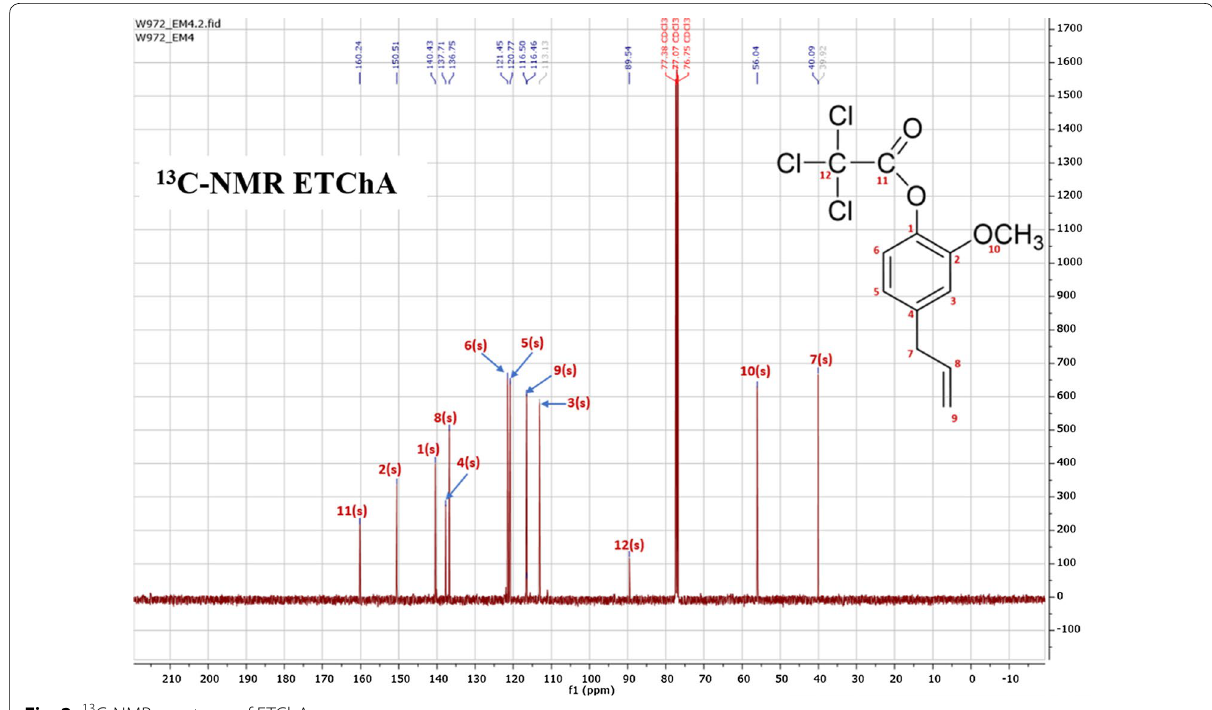
Fig. 2 13 C-NMR spectrum of